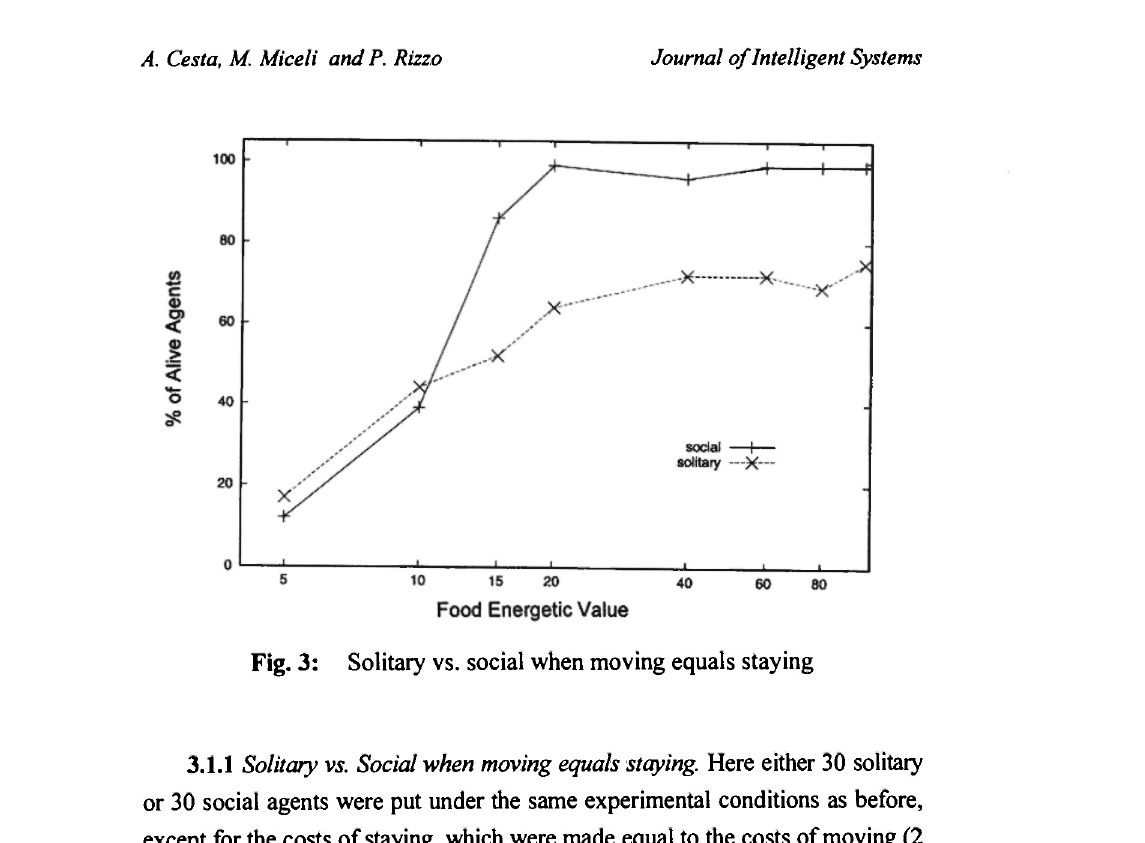
Fig. 3: Solitary vs. social when moving equals